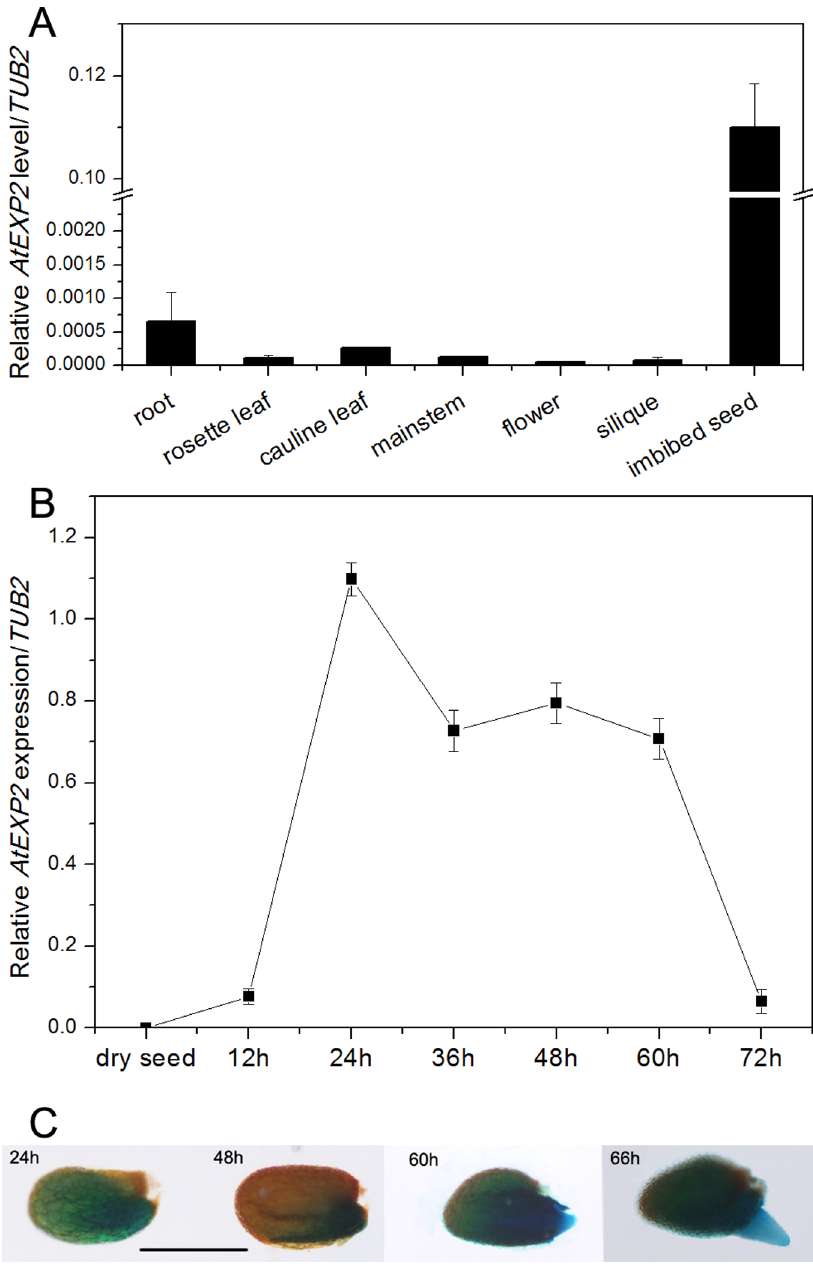
Figure 1. Expression pattern of AtEXP2 gene. (A) Tissue-specific expression of AtEXP2 . Various tissues of Arabidopsis wild type plants were harvested for RNA extraction. (B) Time course of AtEXP2 expression. Dry seeds and imbibed seeds of Col-0 were harvested for RNA extraction. Transcript levels of AtEXP2 were measured by real-time RT-PCR, and the values were normalized against the levels of TUB2 as a control. Error bars represent SD. (C) GUS staining in germinating seeds of the pAtEXP2:GUS transgenic line. Seeds from T 3 homozygous plants of the pAtEXP2:GUS transgenic line were analyzed. Bar=1 mm.